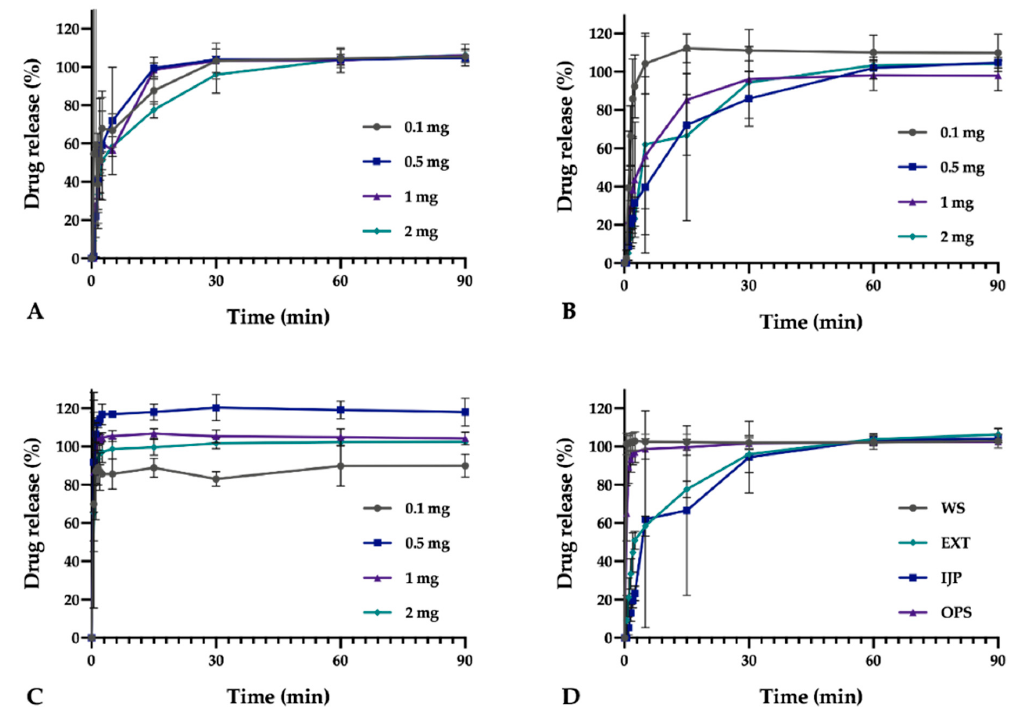
Figure 8. In vitro drug release of the prepared dosage forms in 100 mL of purified water, average ± SD ( n = 3); ( A ) EXT ODFs, ( B ) IJP ODFs, ( C ) OPSs, and ( D ) an overview of all manufacturing methods and pure drug for the 2 mg dose.